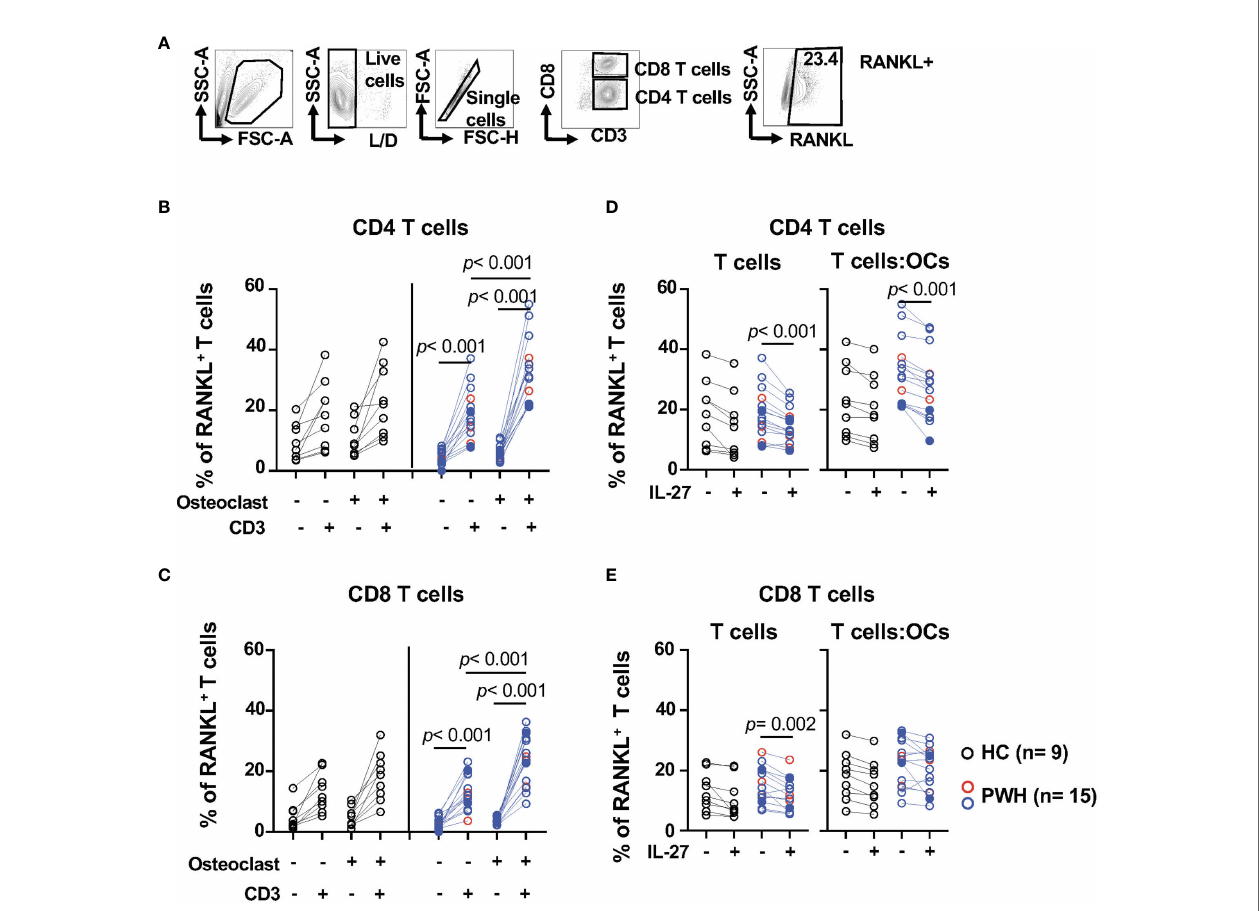
FIGURE 2 | IL-27 modulates the expression surface expression of RANKL in CD4 T cells from PWH. T cells from PWH (n = 3, red symbols, HIV + (T) n = 12, opened blue symbols, Table 1 ) and healthy controls (HC, n = 9, black symbols) were cultured alone or in presence of OCs at a 5:1 ratio (T cell:OCs) were stimulated with CD3/CD28 mAbs. After overnight culture RANKL was measured by fl ow cytometry. (A) Gating strategy and representative contour plot of RANKL surface expression in T cells, (B) Surface expression of RANKL in CD4 T cells, and (C) Surface expression of RANKL in CD8 T cells. T cells cultured alone or in presence of OCs were stimulated with CD3/CD28 mAbs in the presence and absence of IL-27 (50 ng/ml) and RANKL surface expression was measure by fl ow cytometry: (D) CD4 T cells and (E) CD8 T cells. Graph representing RANKL surface expression in T cells. In the graph, solid blue symbols represent individuals with viral loads >50 copies/ml. One-way ANOVA was used for comparisons between culture conditions. Post hoc non-parametric Wilcoxon was used for comparisons between culture conditions. Bonferroni test was used to adjust for multiple comparisons. P -value ≤ 0.003 was considered signi fi cant. Post hoc nonparametric unpaired Mann – Whitney test was used for comparisons between the groups adjusted by Bonferroni test. P -value ≤ 0.01 was considered signi fi